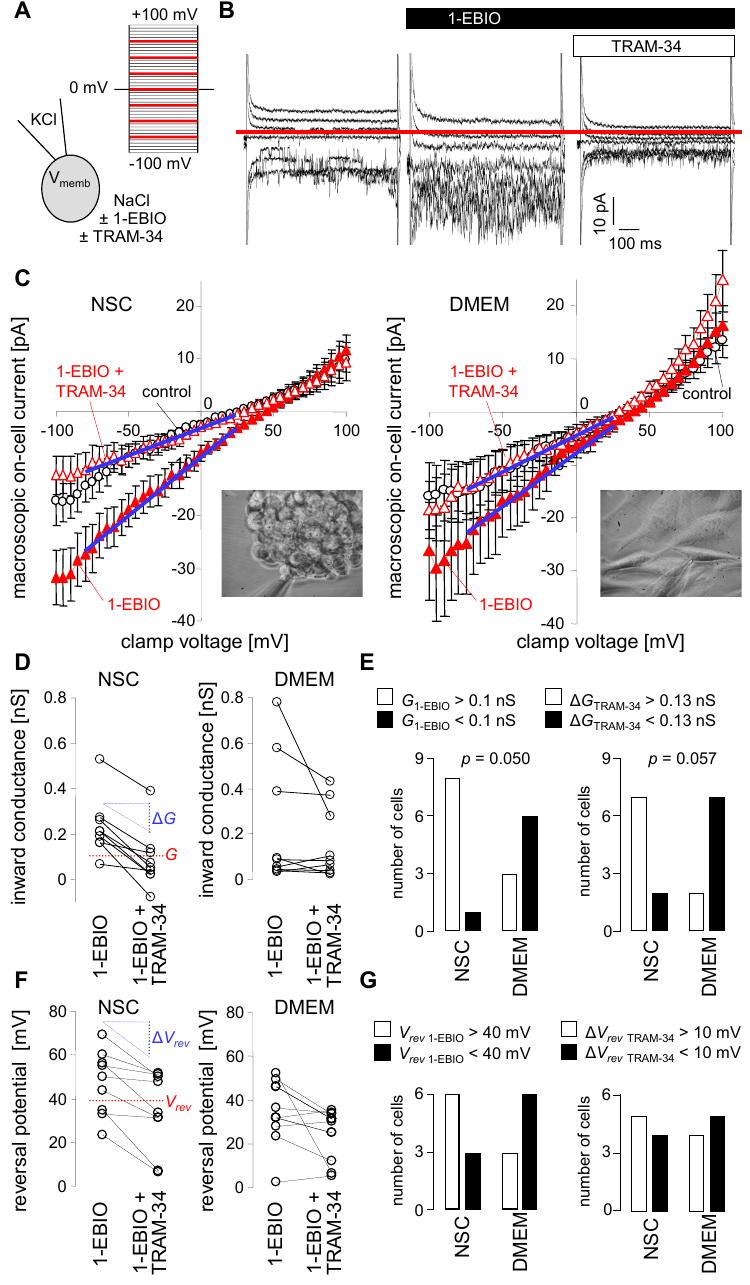
Figure 4. NSC culture conditions induce upregulation of K Ca 3.1 K + currents in the plasma membrane of SMA-540 mouse glioma cells ( A , B ). Ionic composition with channel modulators of pipette and bath solution and applied voltage pulse protocol ( A ) used to record macroscopic on-cell (cell- attached) currents from an NSC-grown (10–14 d) SMA-540 cell. On-cell current tracings depicted in ( B ) were obtained before ( left ), during bath application of the K Ca 3.1 K + channel opener 1-EBIO (200